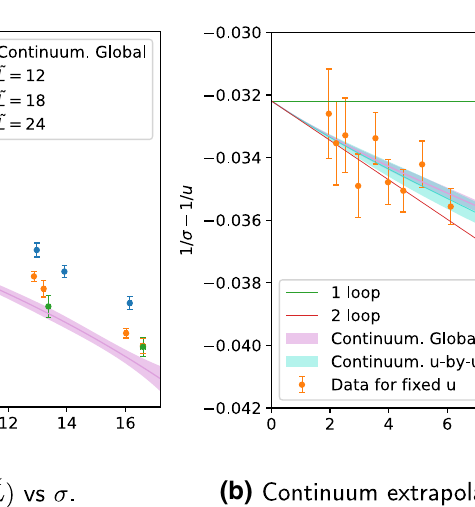
continuum extrapolations derived from the u -by- u and the global fits describedinthetext,correspondrespectivelytotheblueandpinkbands, while the continuous lines indicate the perturbative predictions at order one-loop and